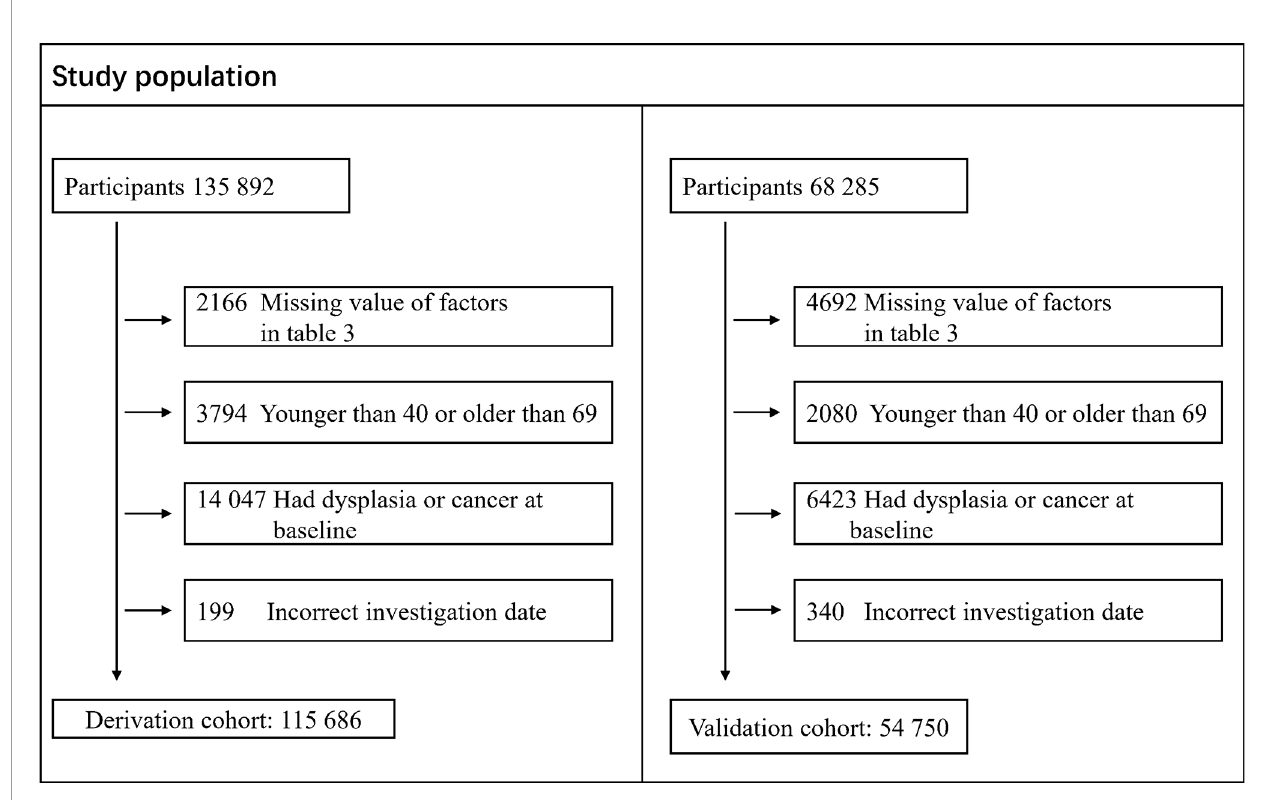
FIGURE 1 | Flow chart of the study population data collation including derivation cohort and validation